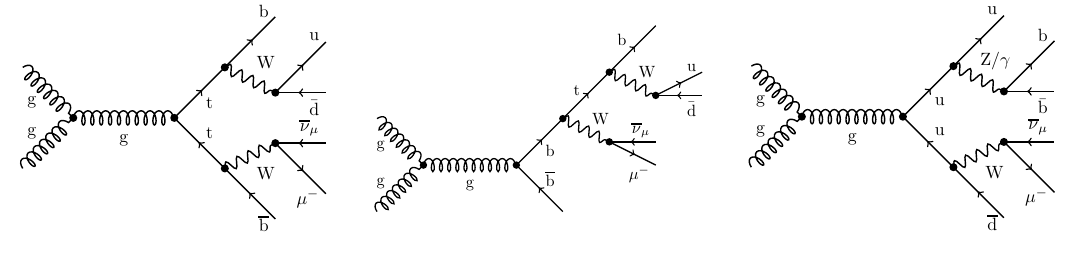
Figure 2. Sample tree-level Feynman diagrams of order diagrams have two resonant top quarks and two resonant W bosons (left) while some have only one resonant top quark and two resonant W bosons (middle) or no resonant top quark and one resonant W boson (right).